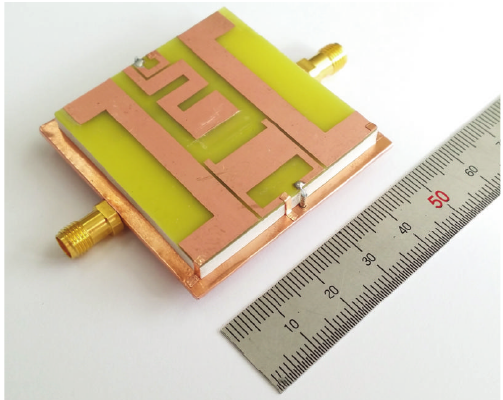
Figure 3: Photo of the fabricated